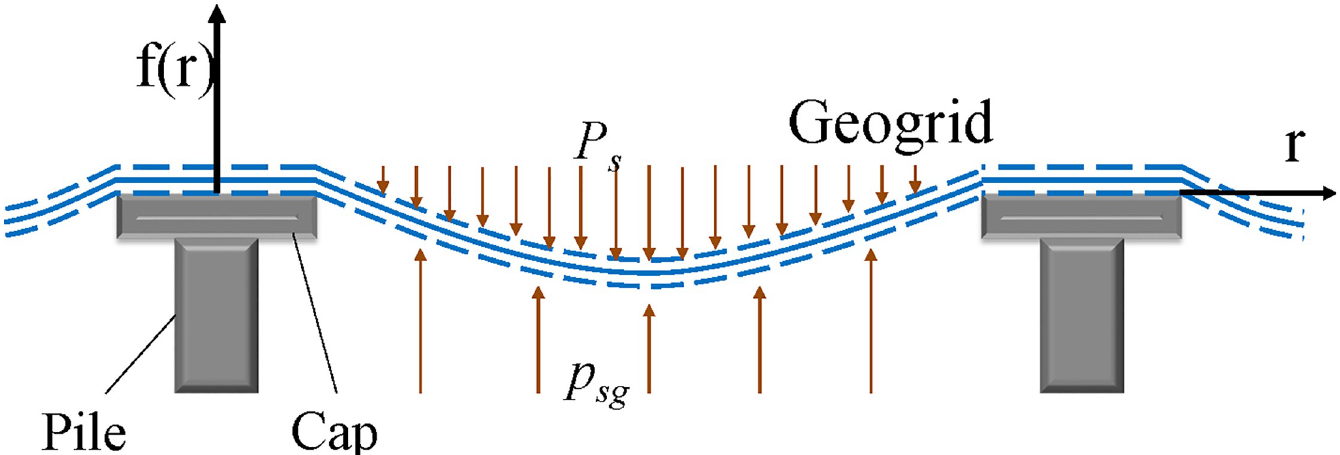
Fig 1. Schematic diagram showing stress of soil between piles for a GRPSE system with single layer of GR.